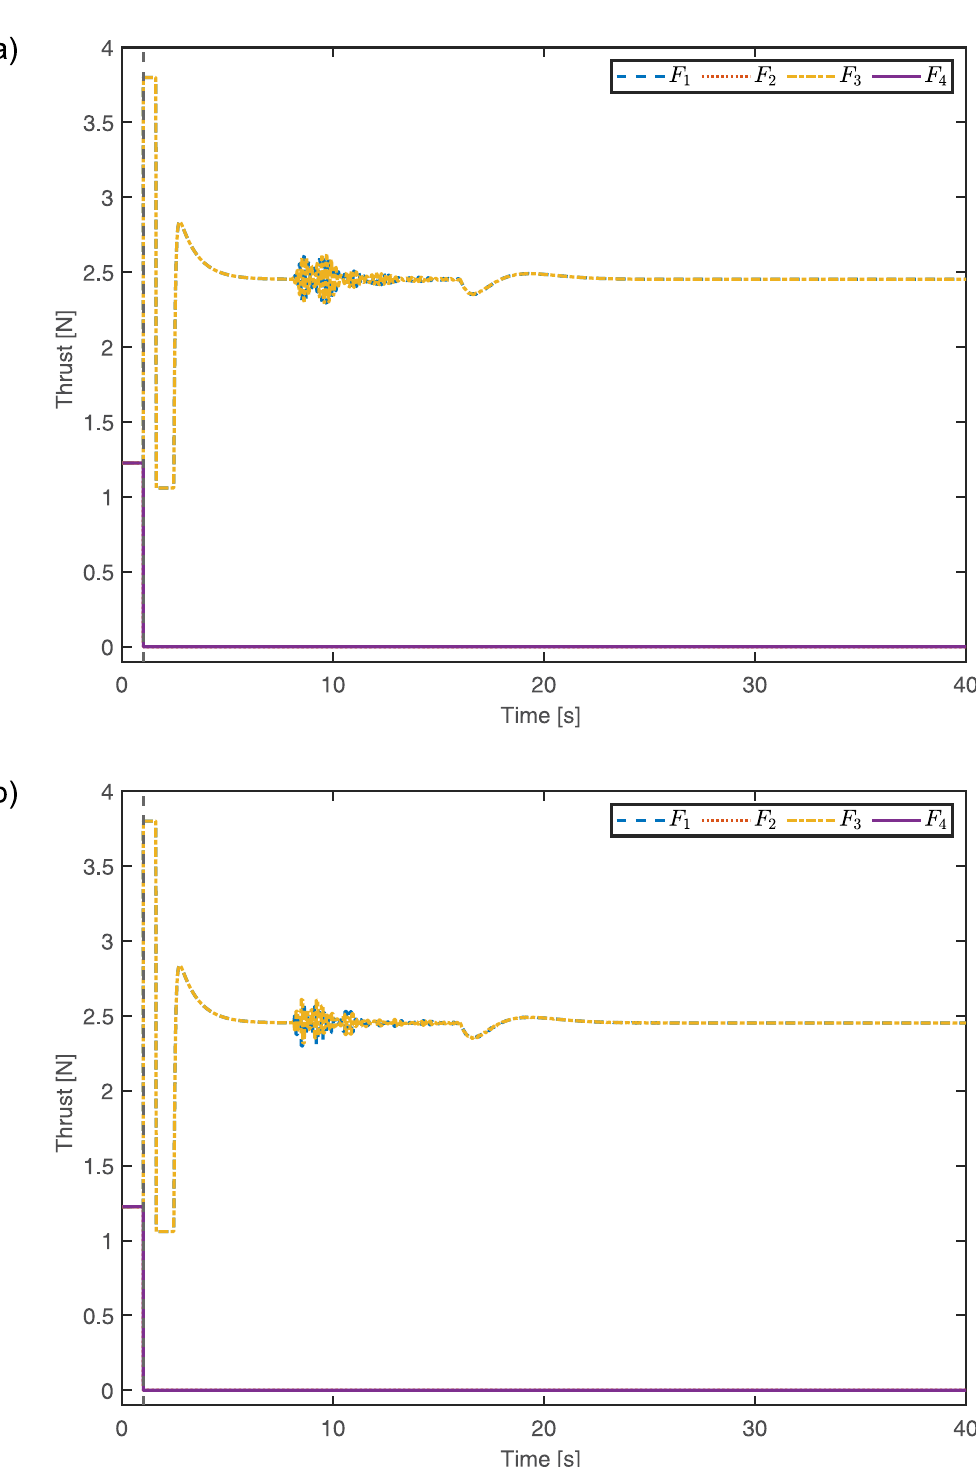
PLOS ONE | https://doi.org/10.1371/journal.pone.0282055 March 3,